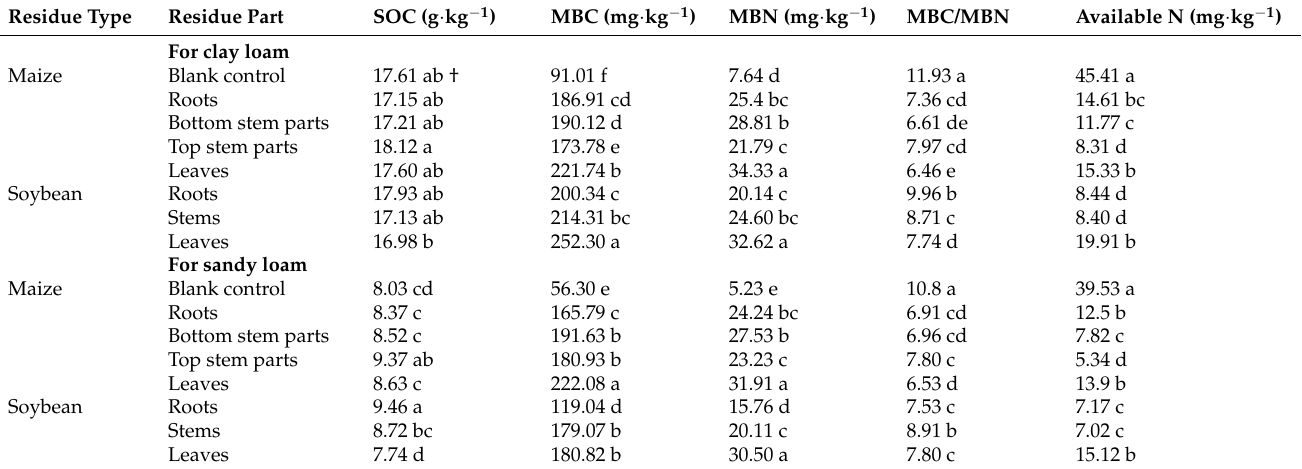
Table 4. The concentration of total organic C, soil microbial biomass and N supply in the two soils amended with different crop residues after incubation for 61 days.